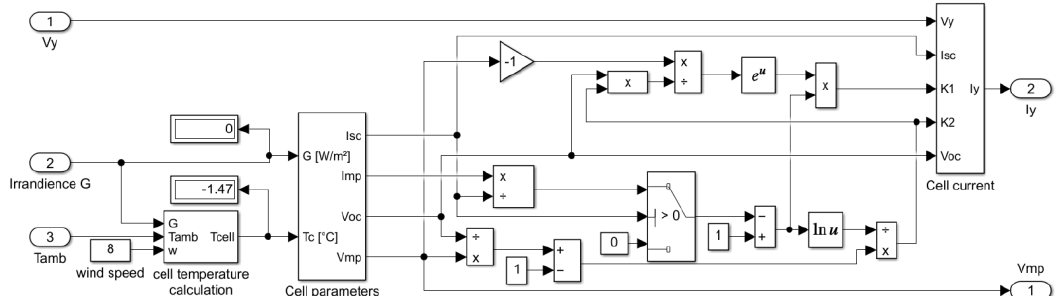
Figure 5. Simulink model of the PV system (own figure based on [25]).